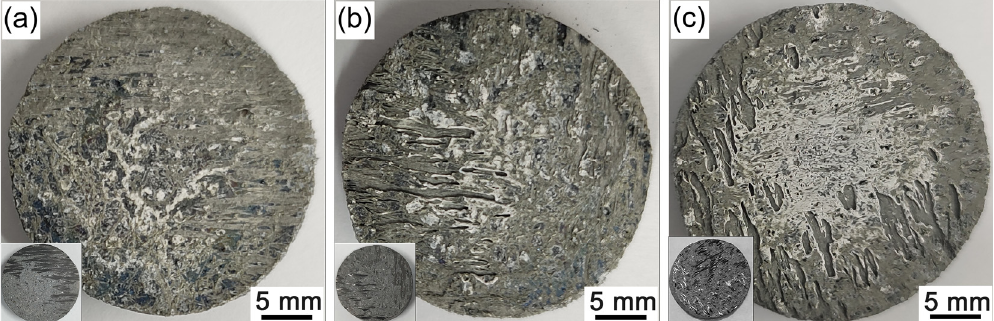
Figure 8. Photographs of the C/C-SiC-(Zr x Hf 1 − x )C composites before and after ablation: ( a ) CMC-1; ( b ) CMC-2; ( c ) CMC-3. ( b ) CMC-2; ( c )